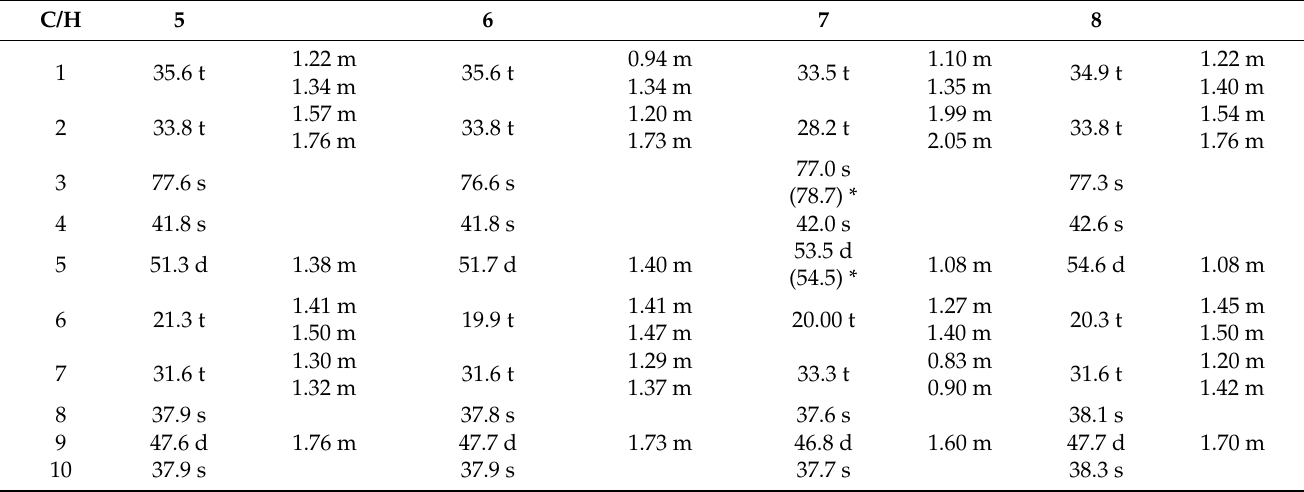
Table 1. 1 H and 13 C NMR spectral data 1 of the new compounds 5 – 8